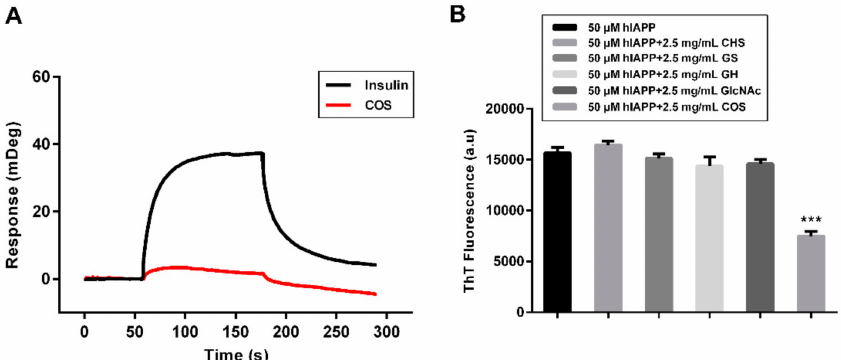
Figure 5. Binding a ffi nity of COS with hIAPP and the e ff ect of di ff erent oligosaccharides on hIAPP aggregation. ( A ) SPR detection of the binding between COS (red) and hIAPP. Mono-hIAPP was immobilized to the CM5 chip. Insulin (black) was used as the positive control. ( B ) ThT fluorescence detection of CHS (chitin oligosaccharides), GS (glucosamine sulfate), GH (glucosamine hydrochloride), GlcNAc ( N -acetyl- d -glucosamine) on hIAPP amyloid fibrils formation.